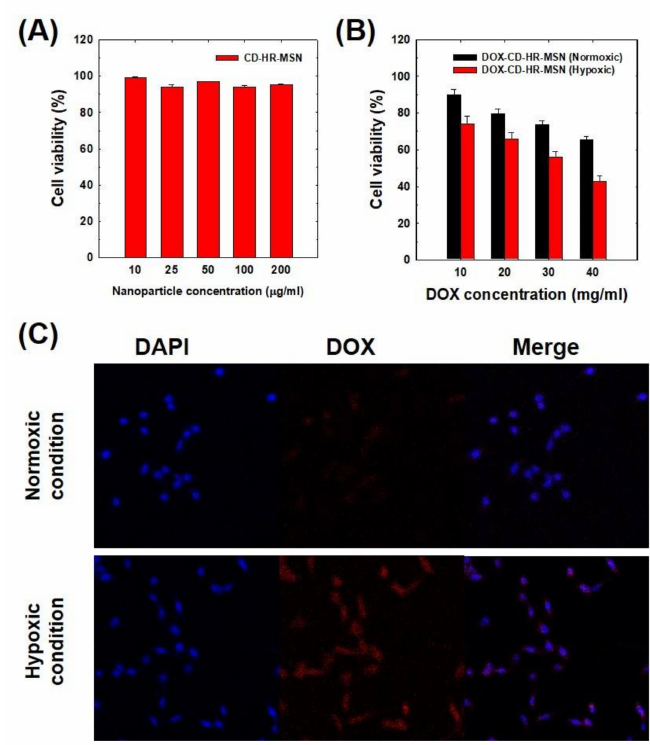
Figure 5. ( A ) In vitro cytotoxicity of CD-HR-MSNs; ( B ) Dose-dependent cytotoxicity of DOX-CD-HR-MSNs; and, ( C ) In vitro confocal microscopic images of SCC-7 cells incubated with DOX-CD-HR-MSNs under normoxic and hypoxic